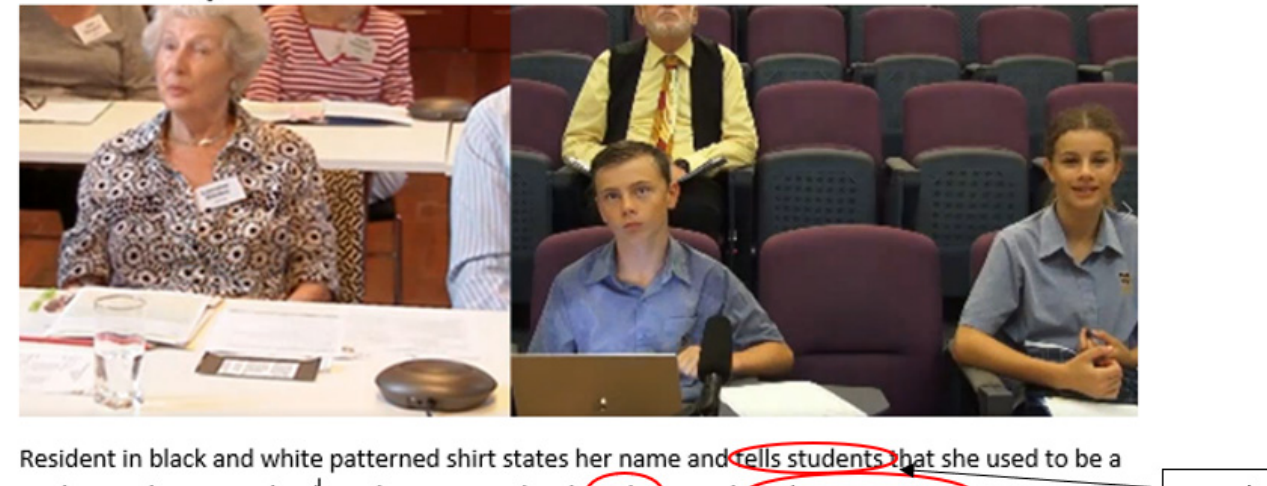
Figure 1. Example of video transcription.